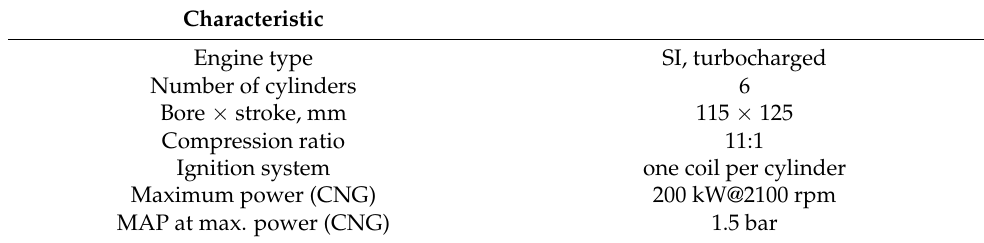
Table 6. Main characteristics of the engine used in the tests when fuelled with CNG.